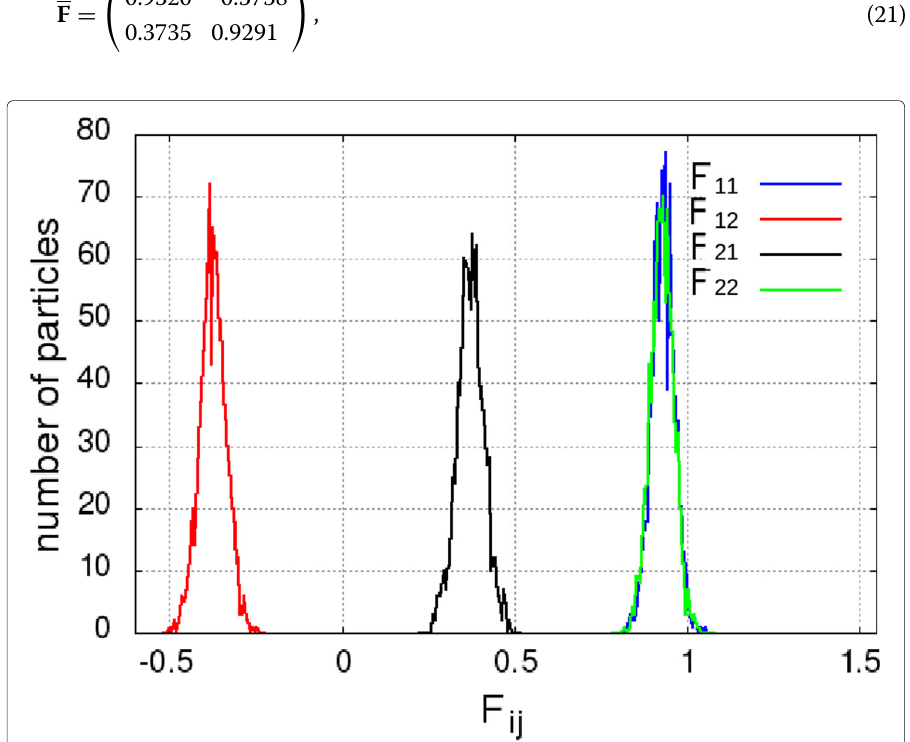
Fig. 15 Histogram of the deformation gradients inside the grain for atoms such that D ( n ) 2 < 0.1 after the grain shrinkage (θ 0 = 21.8 ◦